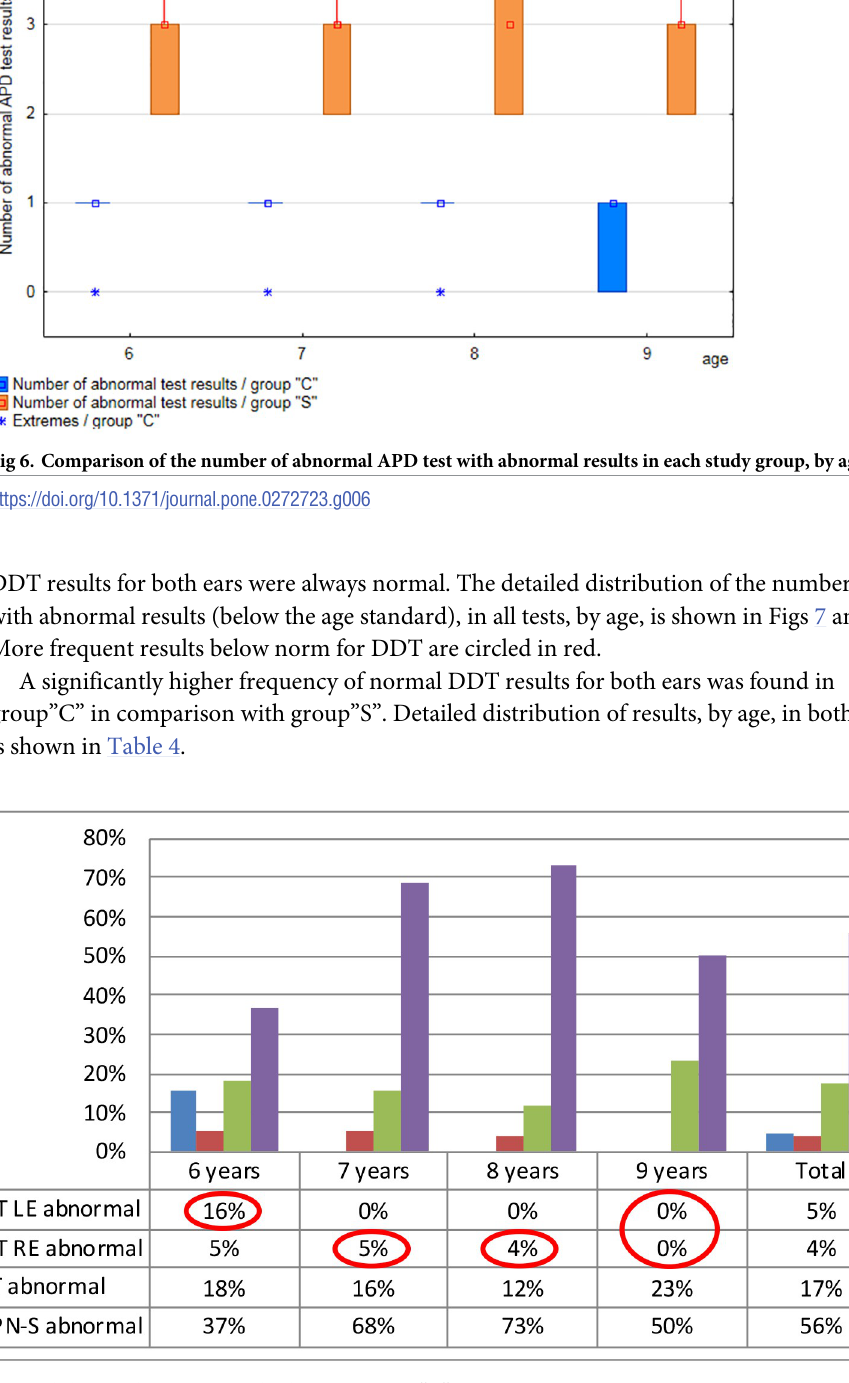
Fig 7. Percentage of abnormal APD test results, by age, in